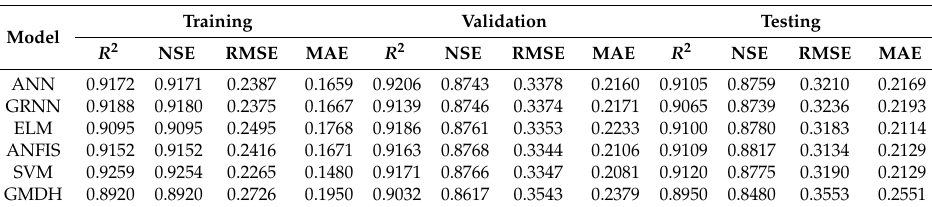
Table 6. Comparisons of data-driven models for evapotranspiration (ET, mm · Day − 1 ) for the training, validation and testing periods.